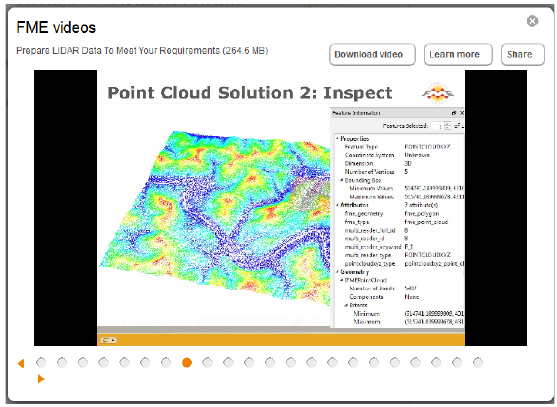
Figure 12: Lecture on Airborne Data Acquisition including annotations